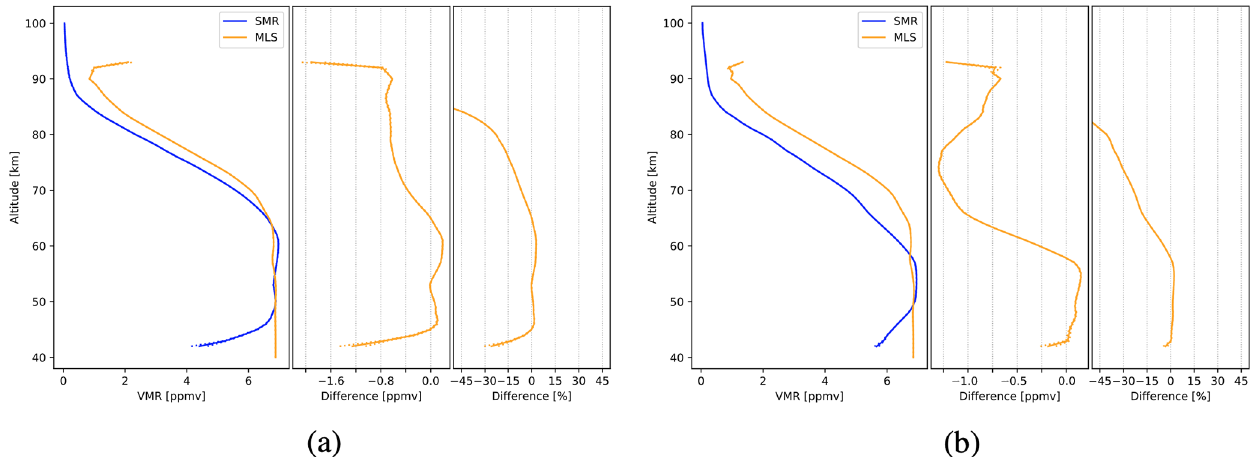
Figure 11. Comparison of SMR H 2 O profiles, from FM13 (a) and FM19 (b) , with those from MLS retrievals. The data plotted are global averages over the period between July 2004 and April 2019. Figure characteristics are the same as in Fig. 6.